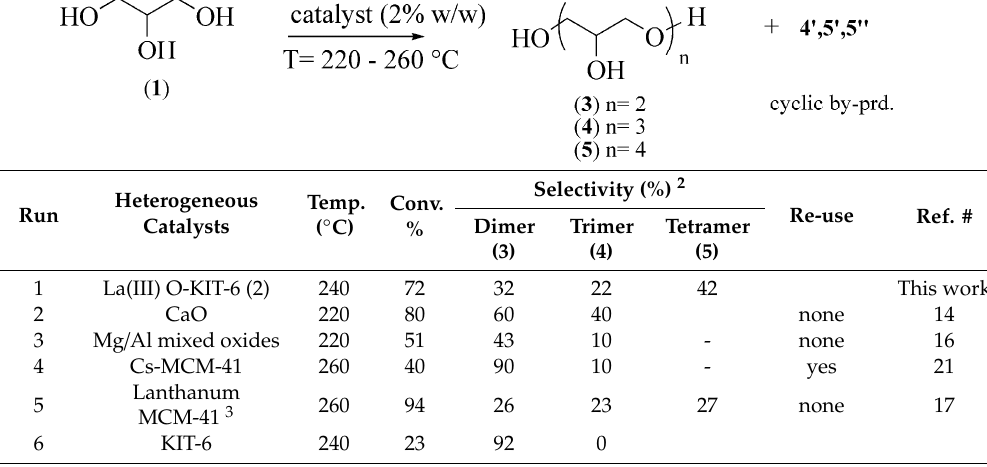
Table 3. Comparison of efficiency of heterogeneous catalyst in glycerol linear oligomerization.